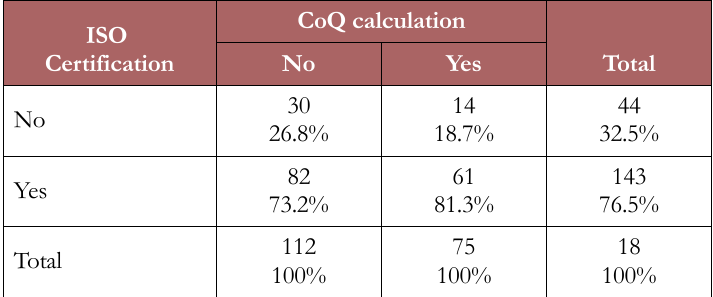
Table 7. ISO Certification * CoQ calculation Cross-tabulation